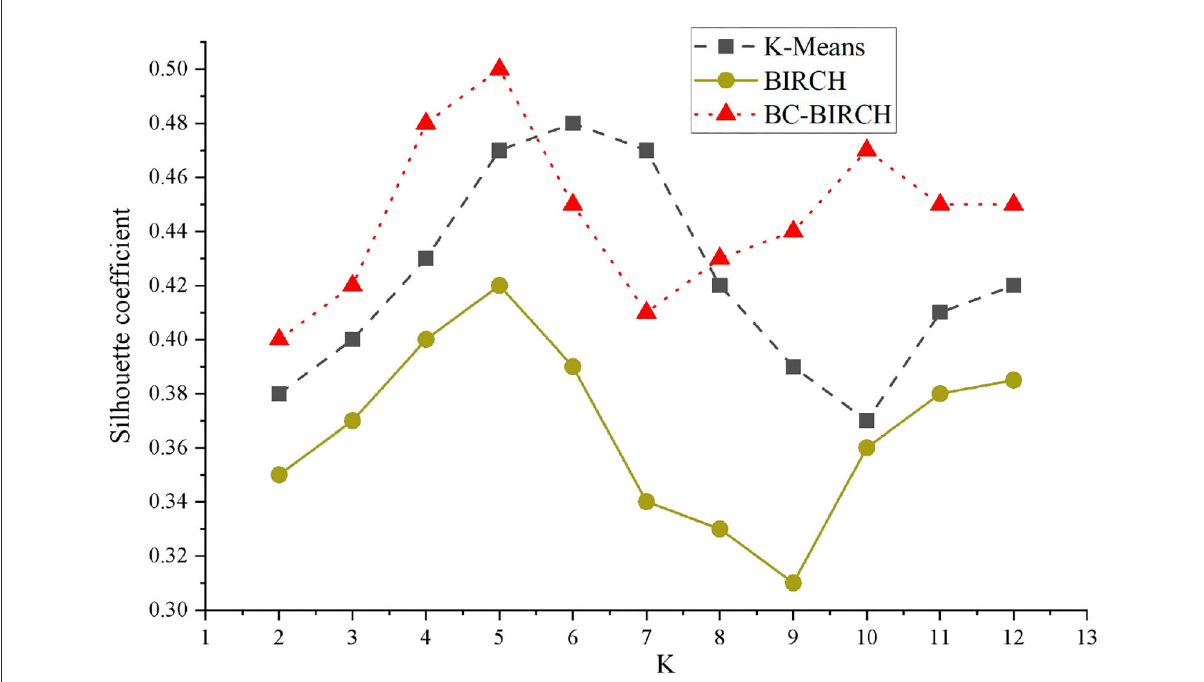
FIGURE5 Comparison of the topic clustering effect.